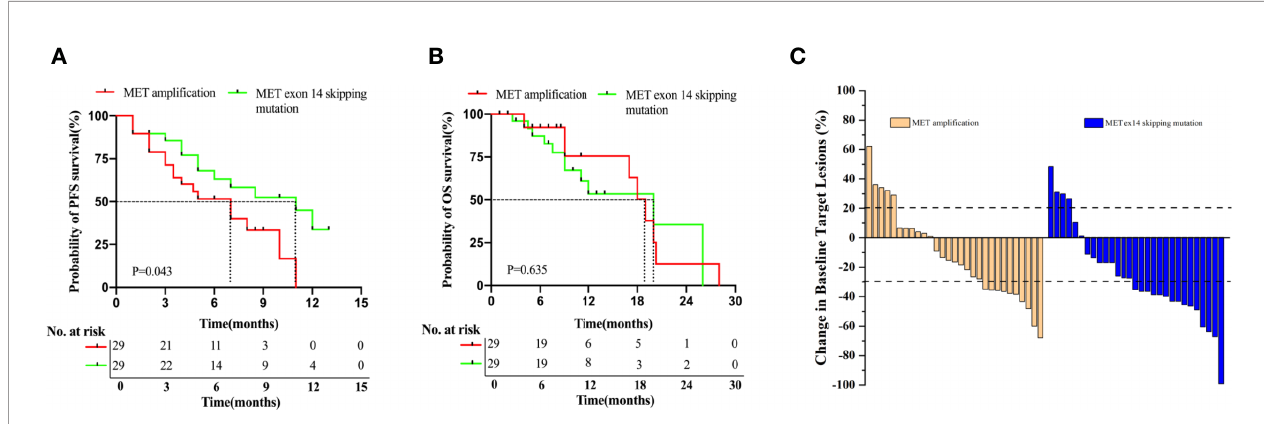
FIGURE 1 | Patients with METex14 skipping mutation treated with MET TKIs have signi fi cantly longer PFS. Kaplan-Meier estimation of PFS (A) , OS (B) , and ORR (C) of MET TKI treated patients with MET ampli fi cation and METex14 skipping mutation. PFS and OS are expressed in months. Dotted line indicates the median survival.